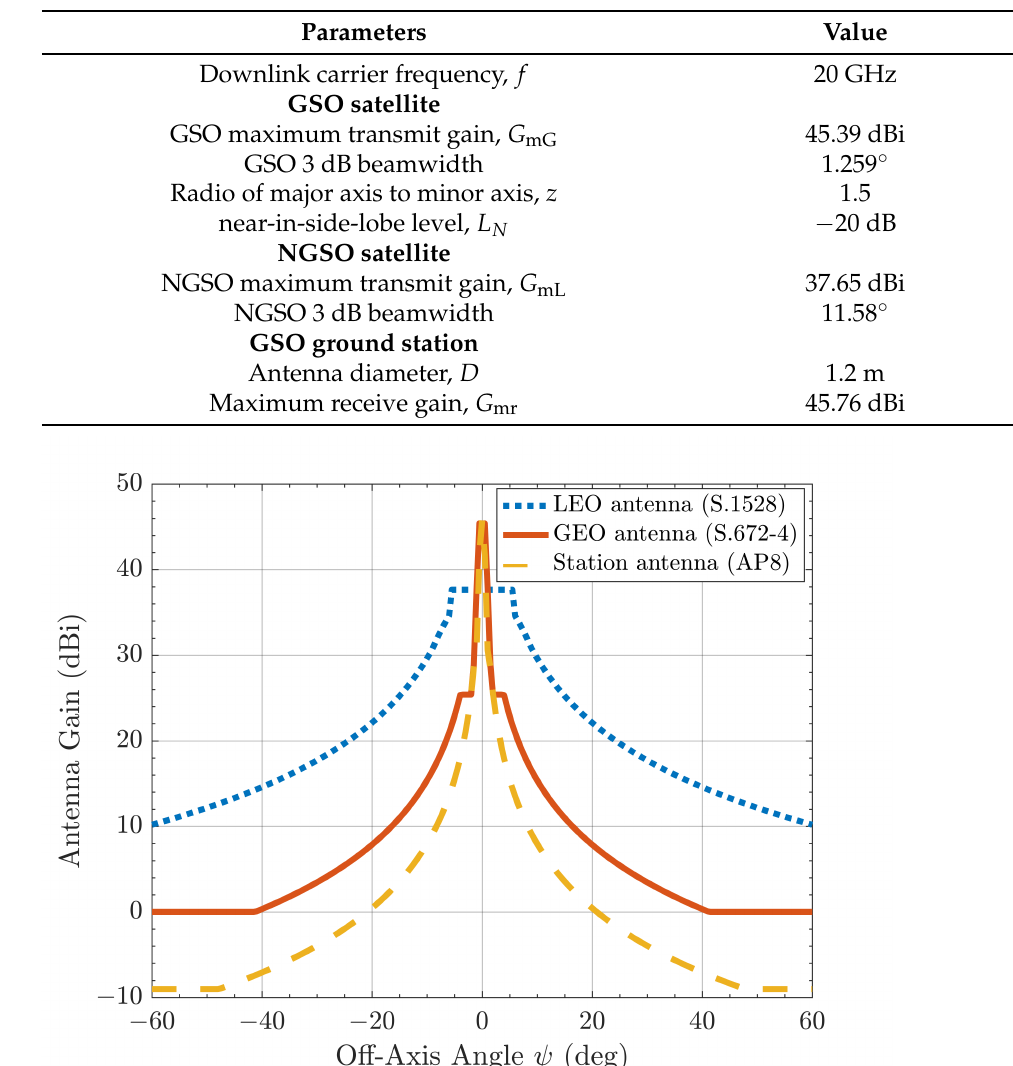
Figure 3. Variation of gain of antennas with off-axis angle for different antenna radiation